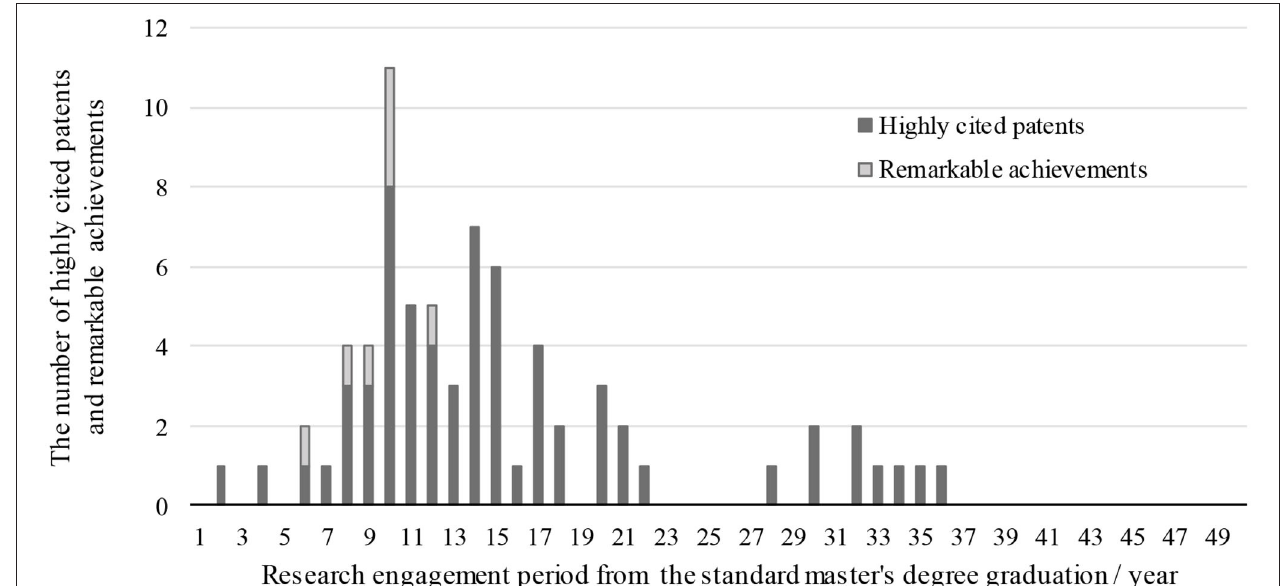
FIGURE 4 | Achievements of star